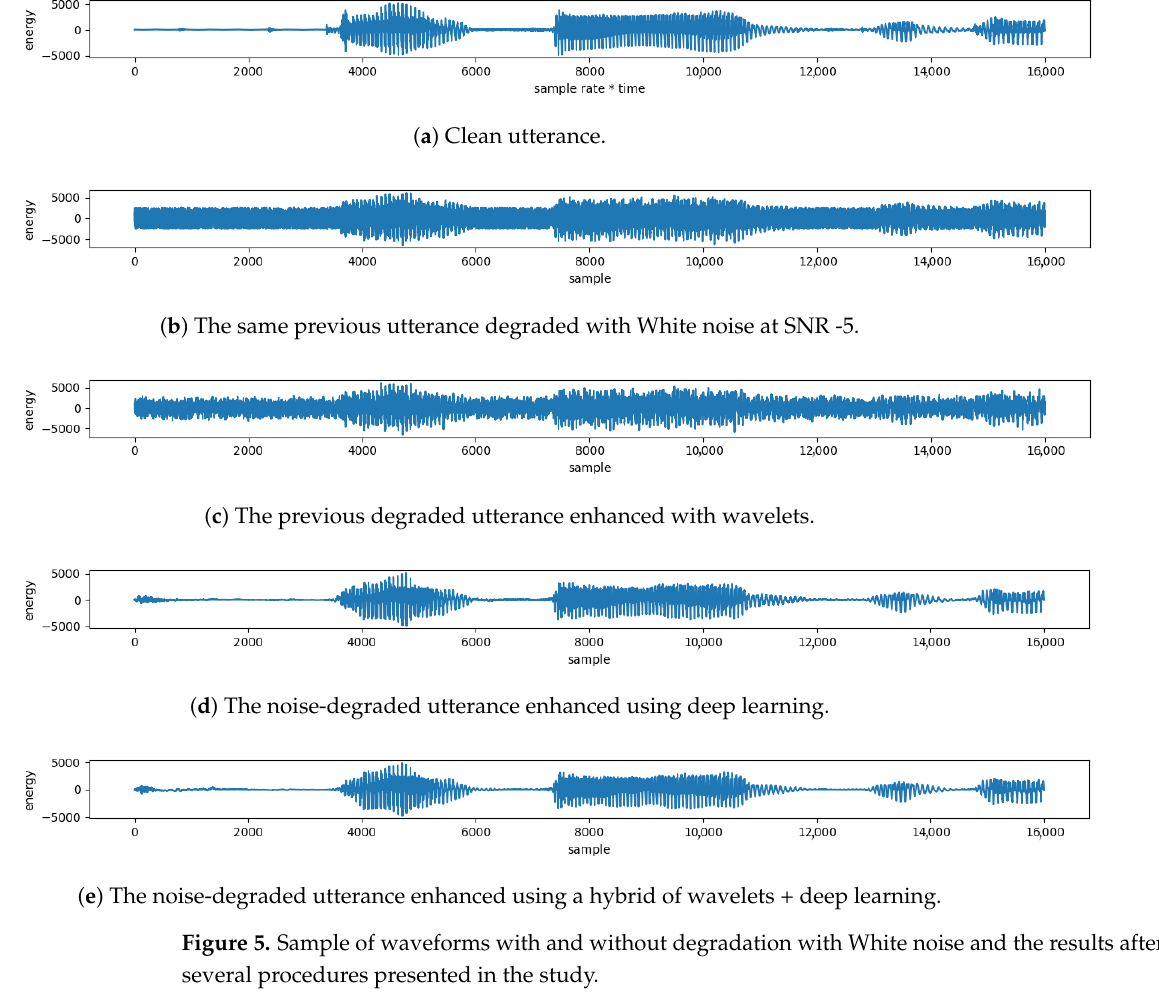
Figure 5. Sample of waveforms with and without degradation with White noise and the results after several procedures presented in the